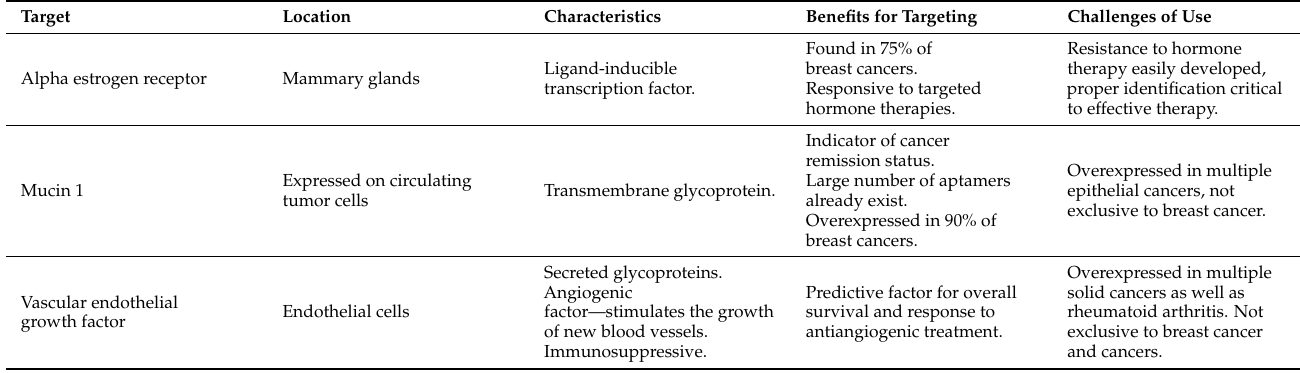
Table 1. The current available targets, their location, special characteristics, benefits for selection as a target, and challenges in